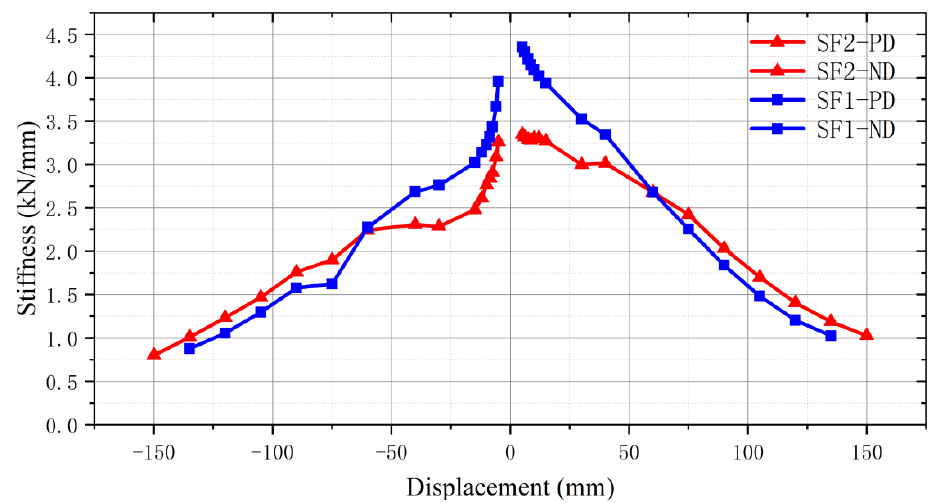
Figure 18. Stiffness degradation curves of SF-1 and SF-2.